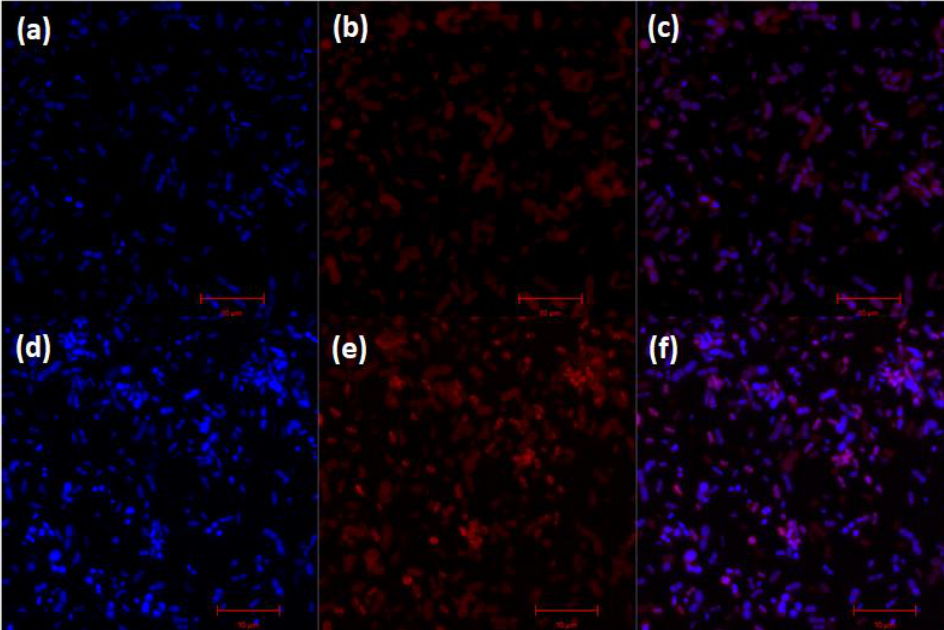
Figure 6. Confocal microscopy of MB and FTC internalization by A. baumannii planktonic cells. ( a , d ) A. baumannii cells with DAPI stained; Internalization of MB ( b ) and FTC ( e ) by A. baumannii cells; The two overlapping images for MB ( c ) and FCT ( f ).